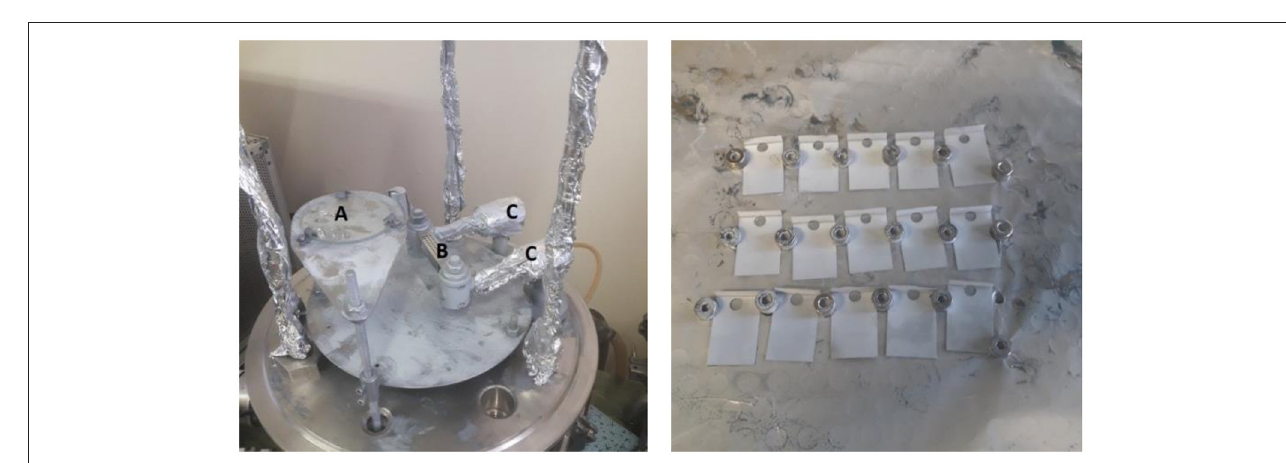
FIGURE 3 | PVD set-up with zinc filled molybdenum boat (picture on the left) with (A) the shutter, (B) the Molybdenum crucible with Zinc granulates and (C) the High Voltage lines – Zinc-coated gold foils (picture on the right).